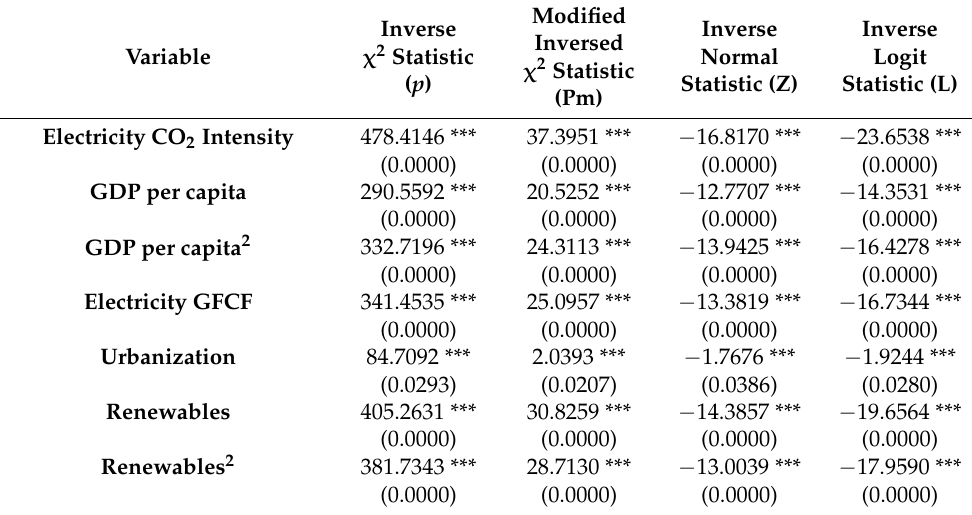
Table 7. ADF–Fisher panel unit root test at first difference